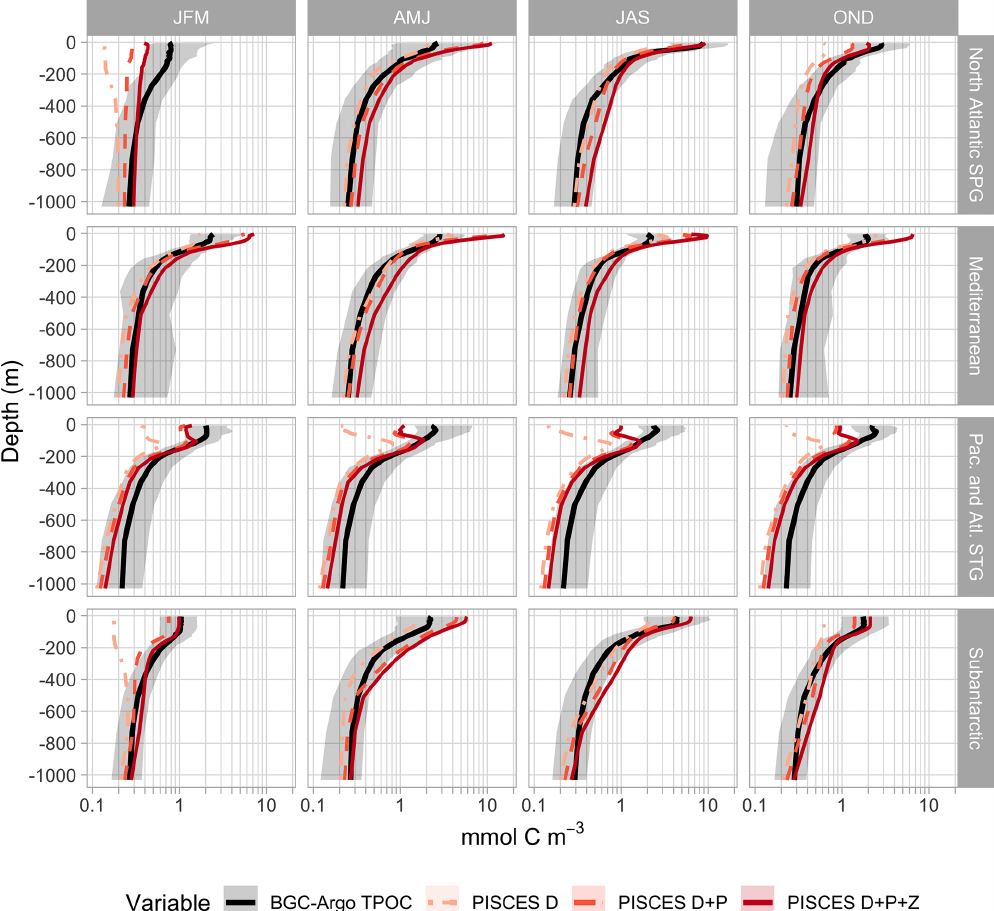
Figure 4. Seasonal 0–1000m profiles of particulate organic carbon (POC). BGC-Argo estimates of TPOC (based on the backscattering coefficient at 700nm, b bp700 ) are represented with the median and the 0.025–0.975 quantiles within each biome. PISCES TPOC results from the addition of the detritus (D), phytoplankton (P), and zooplankton (Z) tracers (Table 2), which are shown here as cumulative